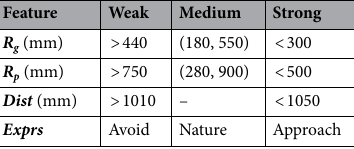
Table 6. The change rule of eigenvalue and intensity of interactive